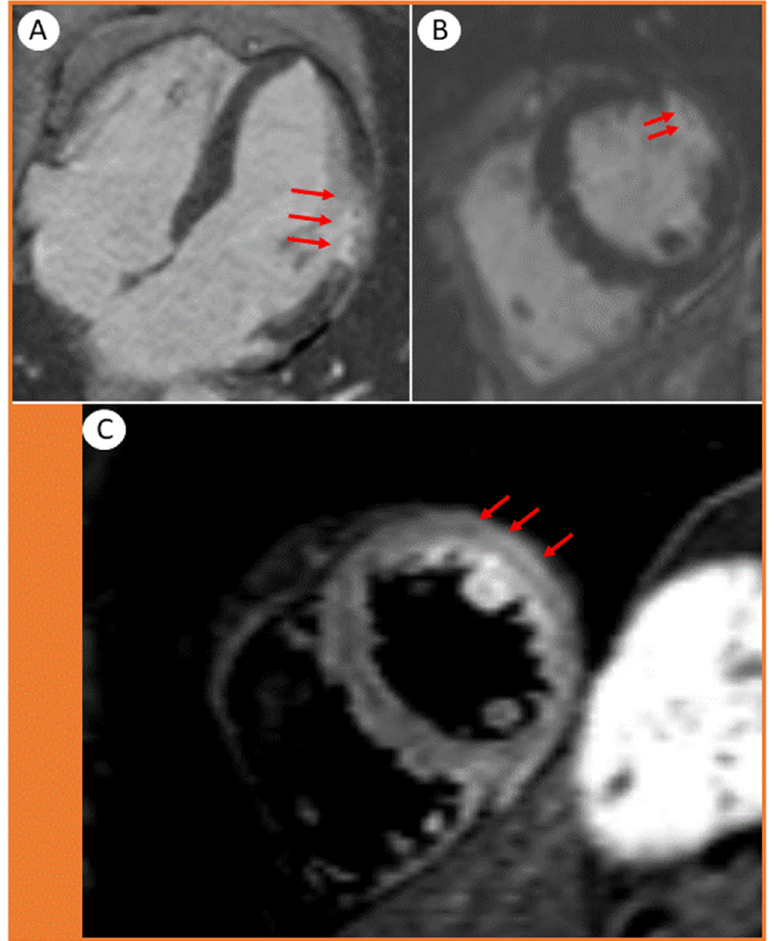
Figure 3. Cardiac magnetic resonance images showing ( A ) 4-chamber and ( B , C ) short axis views. The transmural distribution of late gadolinium enhancement (LGE) in the lateral wall of the left ventricle displays the extent of the infarction. ( B , arrows) Microvascular obstructions are presented as tiny spots within the LGE. ( C , arrows) The short-axis STIR acquisition shows edema in the lateral wall and papillary muscle.